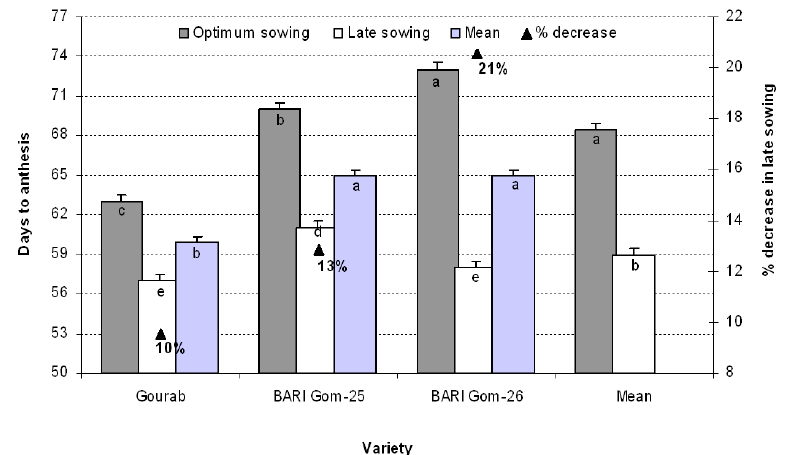
Fig. 6. Days passed to anthesis of 3 wheat varieties when sown under optimum and very late conditions. Mean (±SD) was calculated from three replicates for each treat- ment. Bars with different letters are significantly different at p ≤ 0.05 (LSD test)